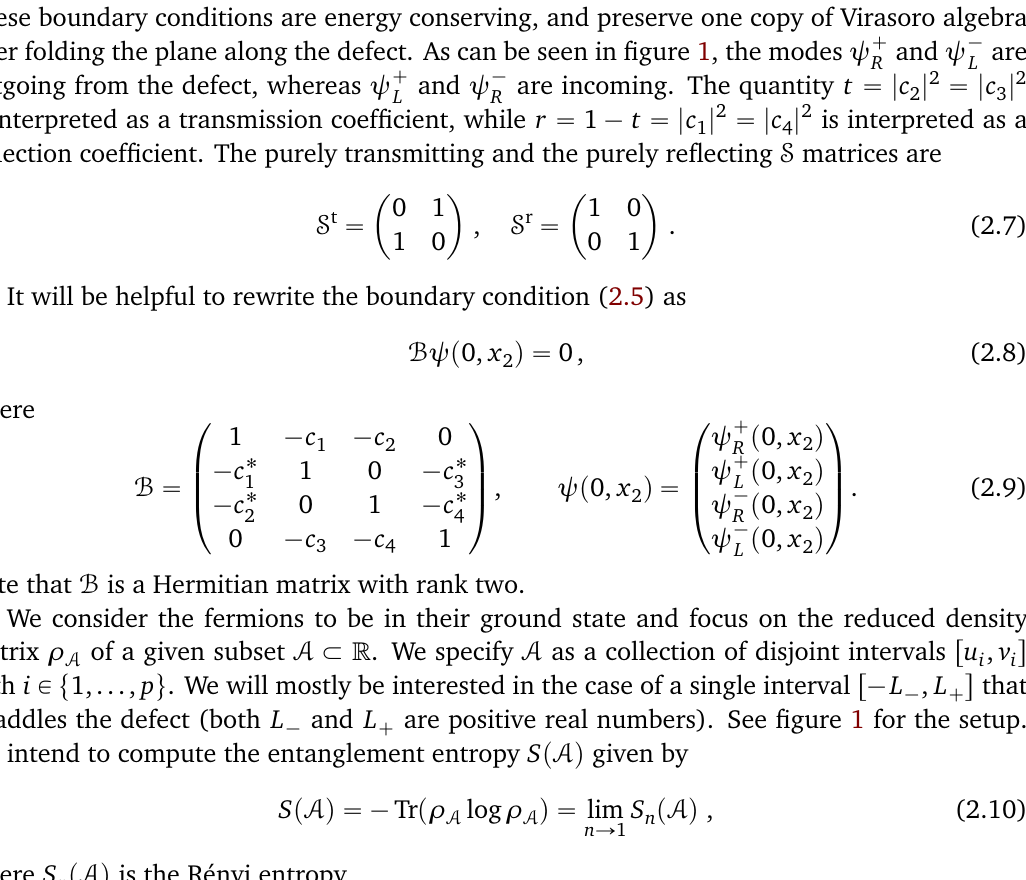
ă 0 and x ą 0 are denoted 1 1 s that , L ´ `